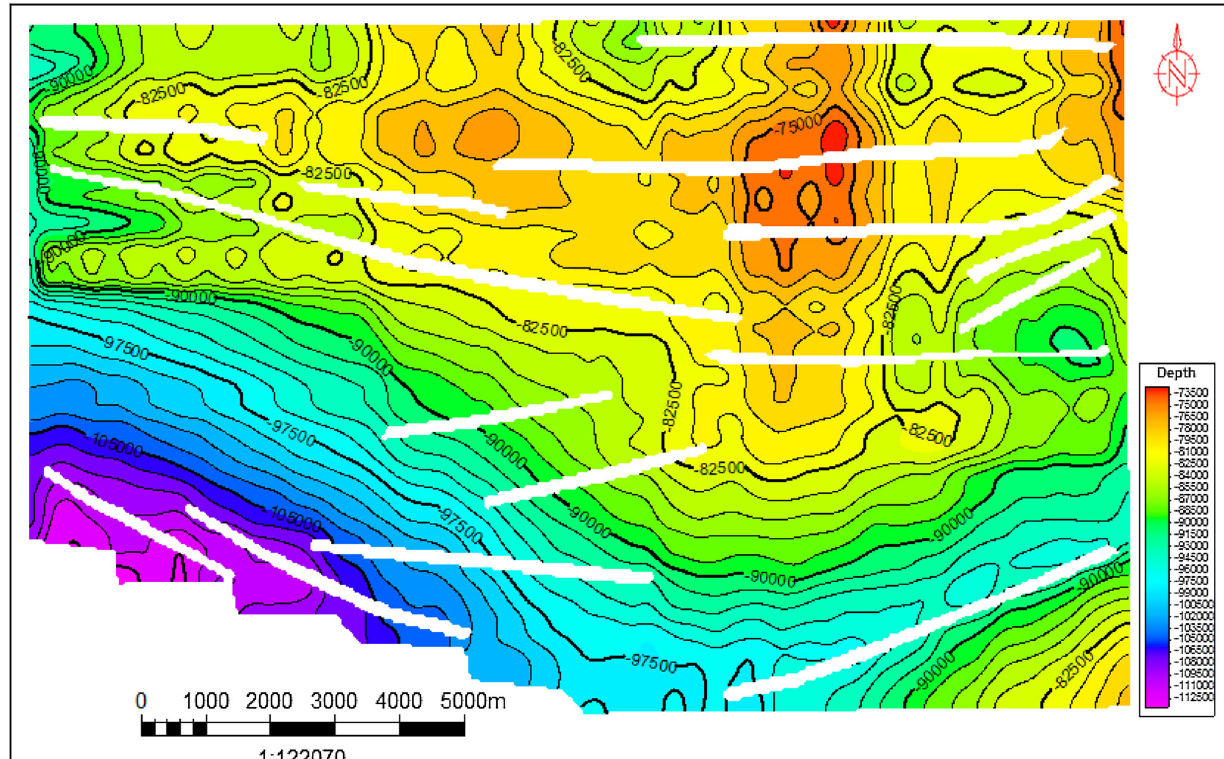
Fig. 9 Structural map for the F-sand top in depth, showing the numerous faulted